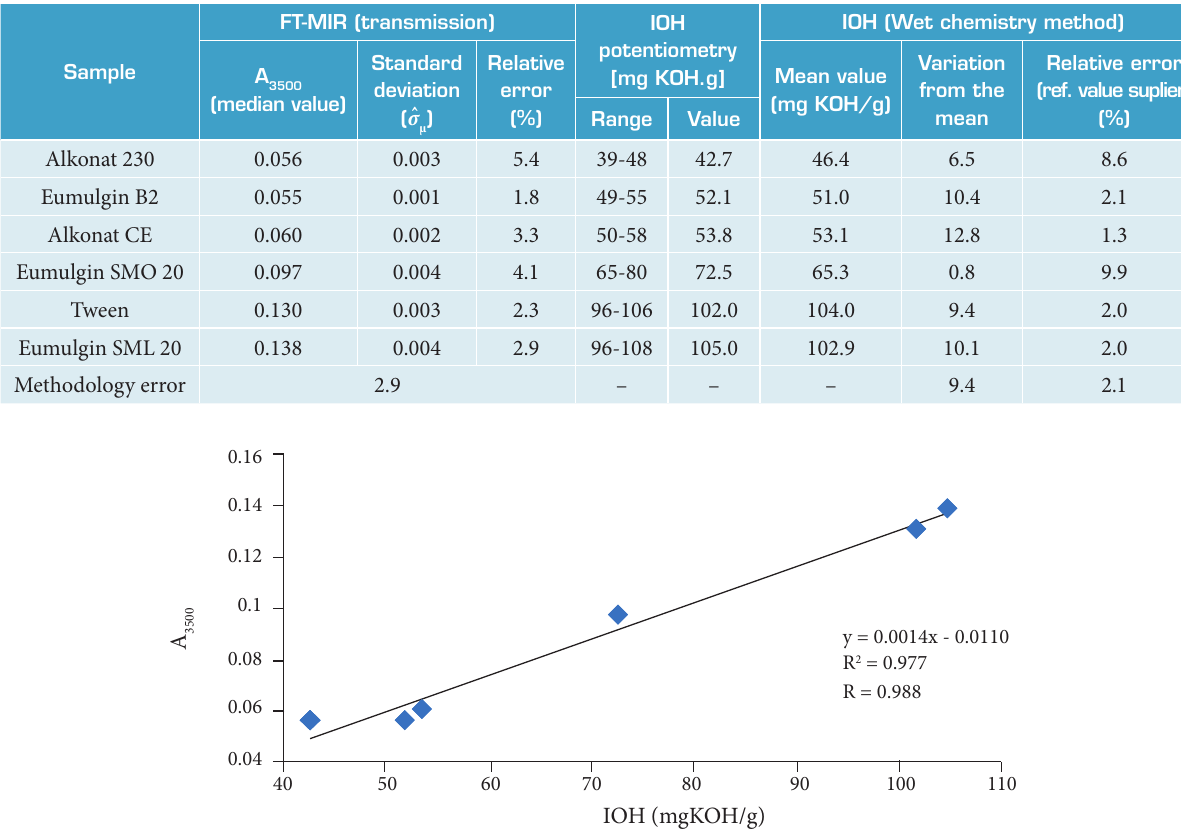
Table 3. Methodologies data, FT-MIR (transmission), potentiometry, and wet chemistry for IOH determination in surfactants.